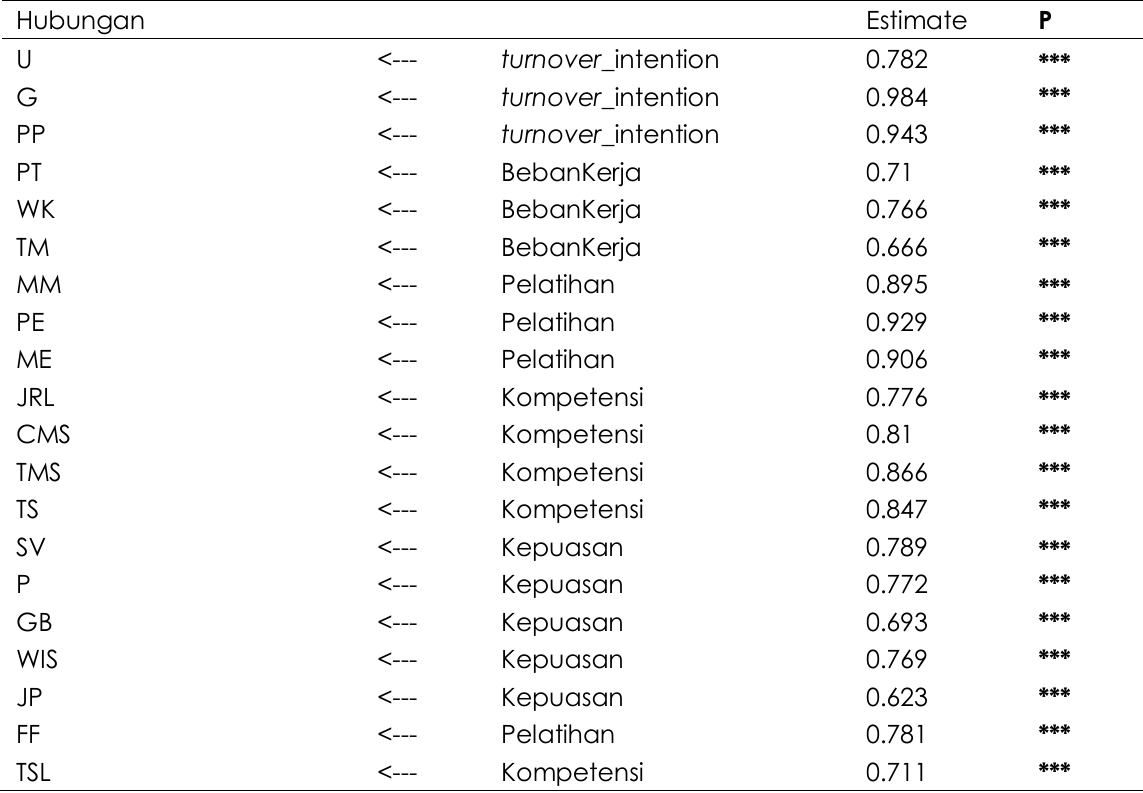
Tabel 5. Loading Factor Hipotesis Penelitian